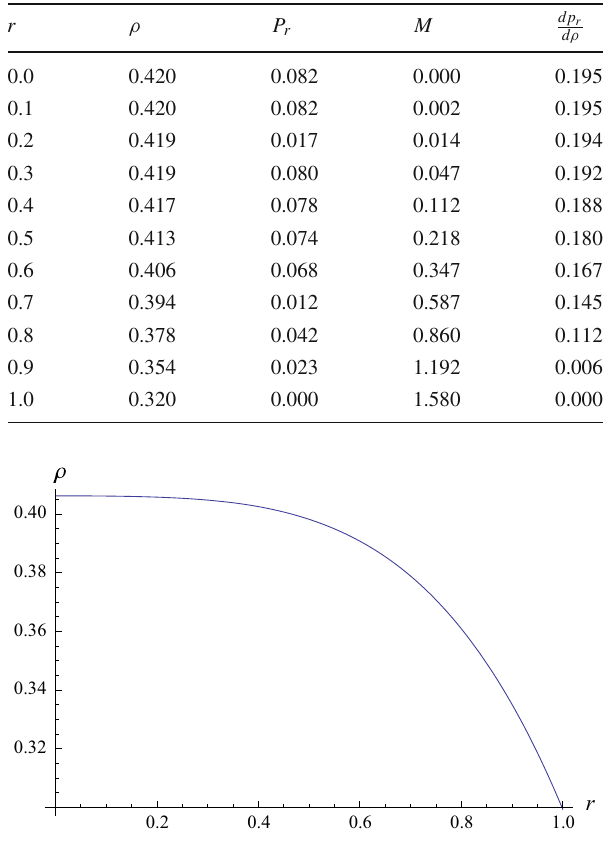
Fig. 1 Energy density for r = 1 and α = 1 . 95 and b = − 10 . 69